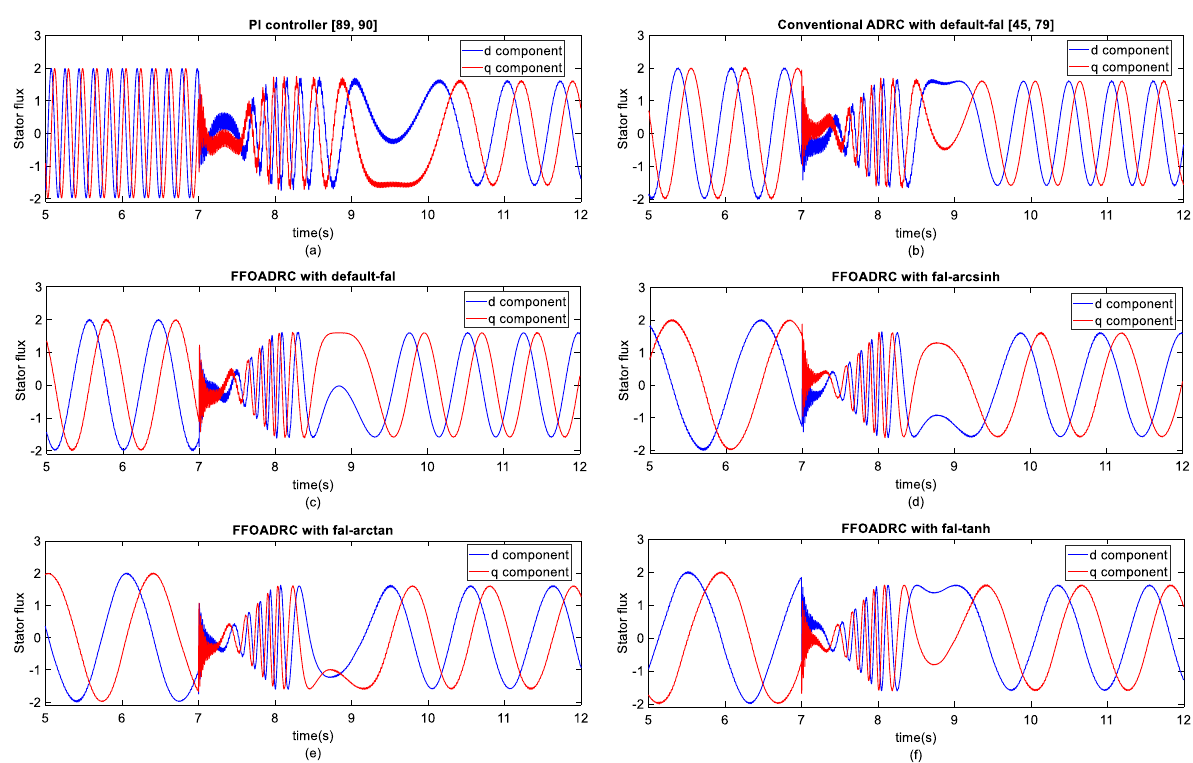
Fig. 16 The d and q components of the stator flux during symmetrical voltage sag for R crowbar ADRC with default-fal [45, 79], ( c ) FFOADRC with default-fal, ( d ) FFOADRC with fal-arcsinh, ( e ) FFOADRC with fal-arctan, and ( f ) FFOADRC with fal-tanh